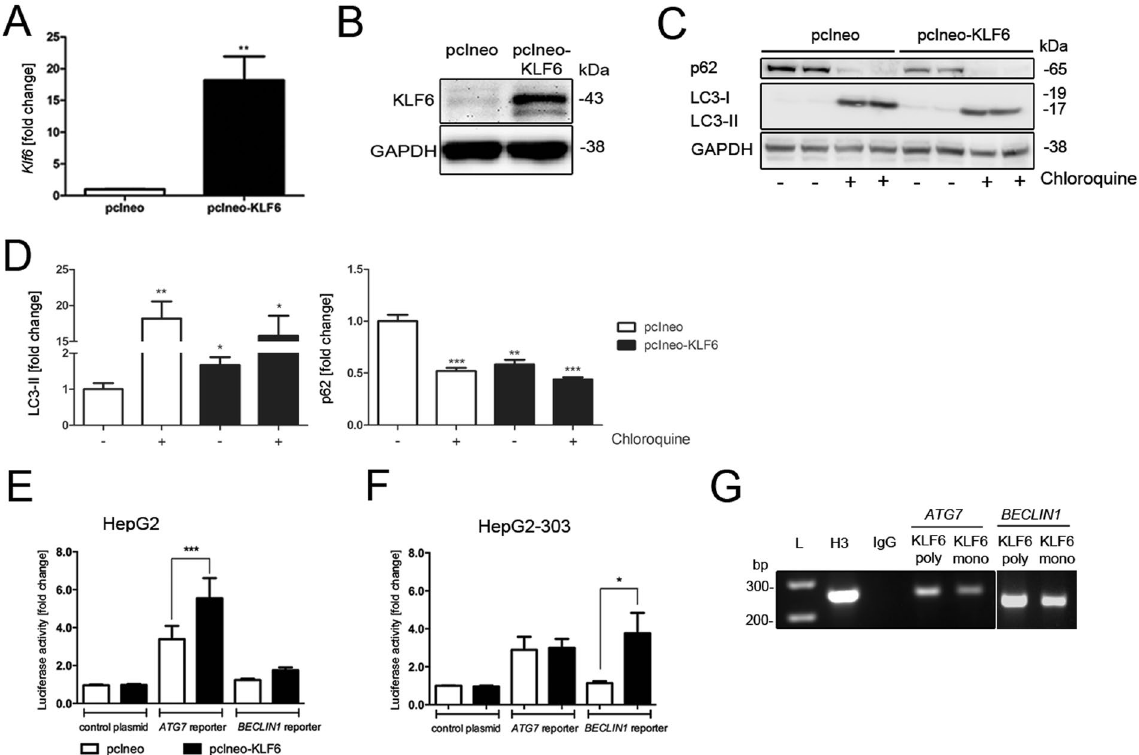
Figure 4. KLF6 transcriptionally activates autophagy-related genes in a p53-dependent manner. Transfection with the KLF6 -expression vector pcIneo-KLF6 induced KLF6 mRNA ( A ) and protein ( B ) expression. KLF6- over-expression induces autophagy in HepG2 cells as assessed by LC3 Western blotting ( C ) and quantification of LC3-II-bands normalized to loading control GAPDH ( D ; fold change versus control shown as mean ± SEM of n = 3 independent cell culture experiments; full length Western blot images are given in Supplementary information.). Autophagic flux was assessed by LC3-II and p62 Western blotting in HepG2 and pcIneo-KLF6 transfected cells in absence ( − ) or presence ( + ) of 100 µ M chloroquine for 24 h (( C ) shows representative Western blot images, ( D) shows fold change versus control, shown as mean ± SEM of n = 3 independent experiments). Activation of the ATG7 and BECLIN1 promoter was quantified by luciferase activity in a co- transfection experiment of pcIneo-KLF6 with specific promoter reporter luciferase plasmids in HepG2 ( E ) and in p53-deficient HepG2-303 cells ( F ). The interaction of KLF6 with the ATG7 and BECLIN1 promoter containing putative KLF6-binding sites was confirmed by chromosomal immunoprecipitation (ChIP) in HepG2 cells ( G ) using two different KLF6 antibodies, IgG as negative controls, Histone-H3 antibody was used as a positive control for ChIP; full length images of agarose gels are given in Supplementary